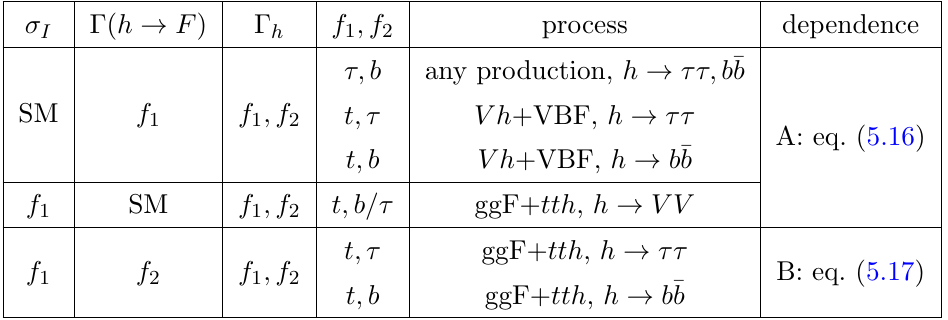
for two modi(cid:12)ed Yukawa couplings of I . SM denotes that the i